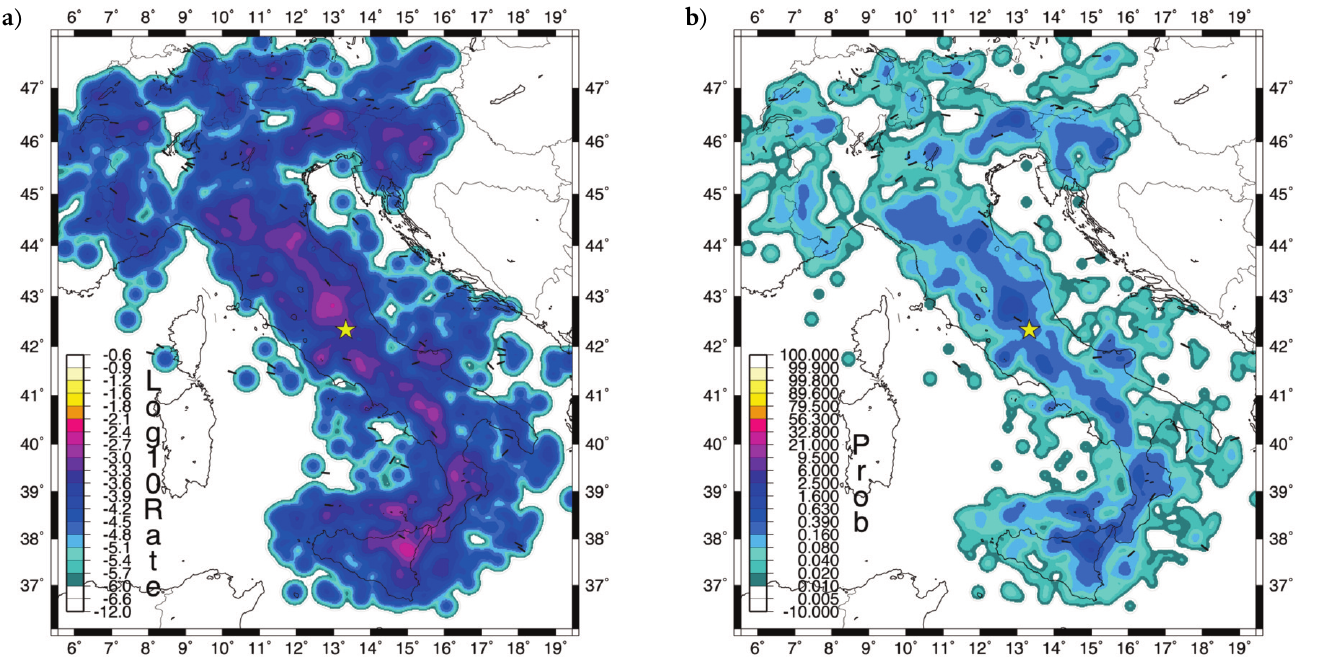
≥ 5.0 events per year in each cell) for the combined case, for submission to the CSEP Testing L ≥ 5.0 predicted in 10 km × 10 km cells around each location. rates of events per year for M 10 L